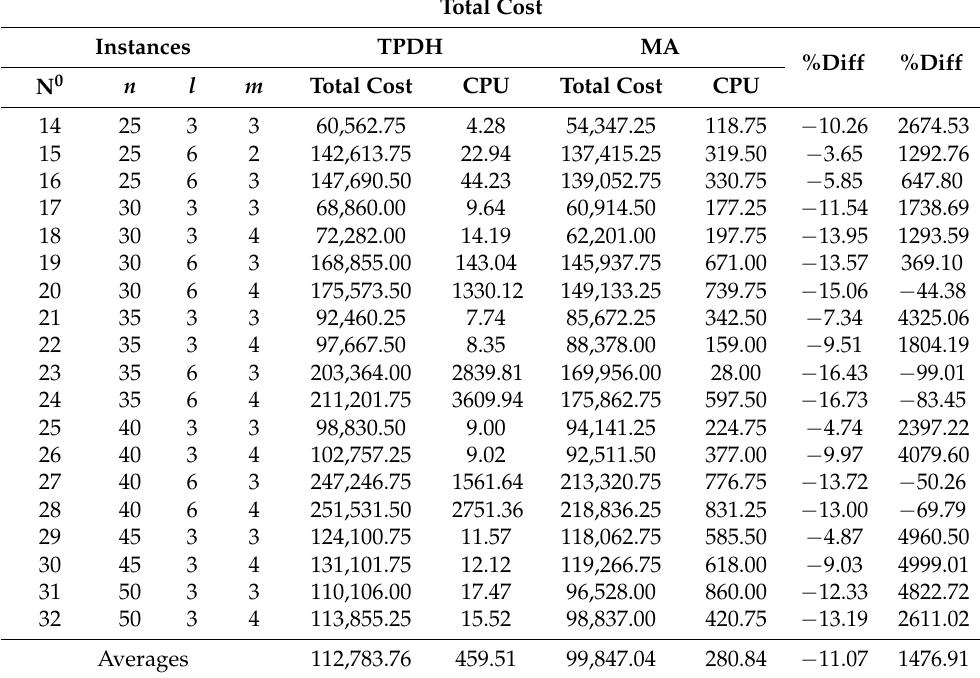
Figure 2. Overall cost comparison.